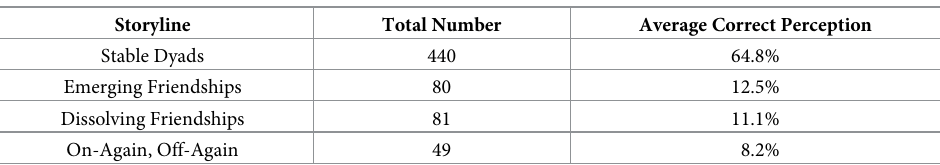
Table 2. Perception of